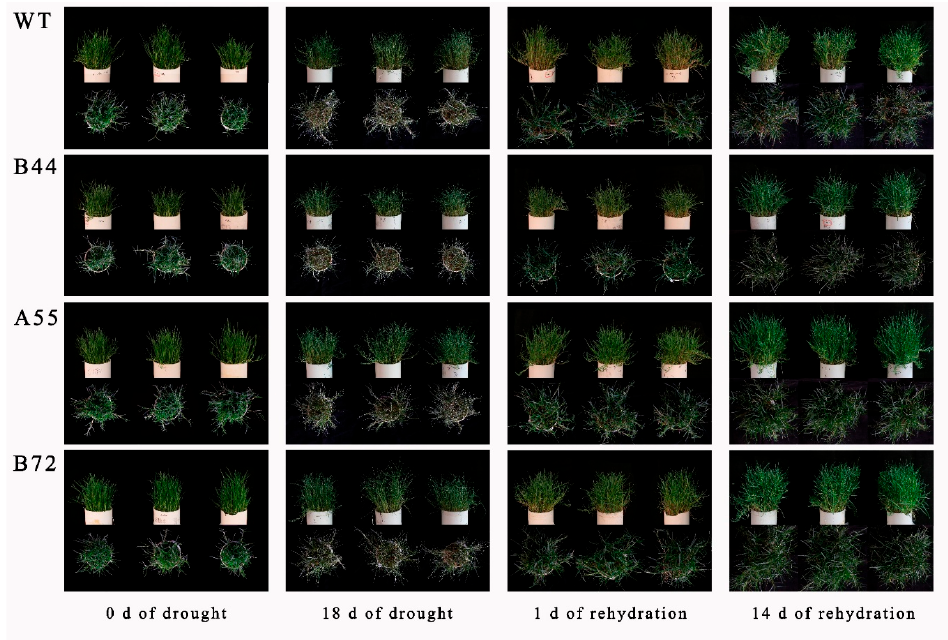
Figure 6. The performance of WT and three excellent drought-resistant materials at different stages of treatment. 3.6. Evaluation of Cold Tolerance of Mutants The EL of WT exposed to − 7 ℃ for 12 h was significantly higher than that of B59, which was consistent with the phenotype (Figure 7A–F). After cold treatment at − 7 ℃ for 12 h, WT was severely damaged after 24 h thawing, with wilted and blackened leaves, yellowed leaf sheaths, and weakened stem segments. The performance of B59 was differ- ent, but there were differences among replicates. Replicate b maintained a better perfor- mance and was not affected. The performance of replicates a and c was the same as WT basically, but there were still some leaves and stem segments that maintained good me- chanics and color and replicate a performed better.